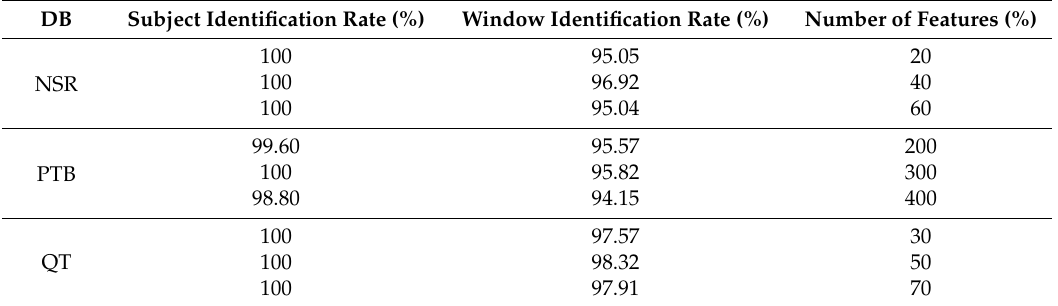
Table 4. Comparison of results according to the number of features with support vector machine